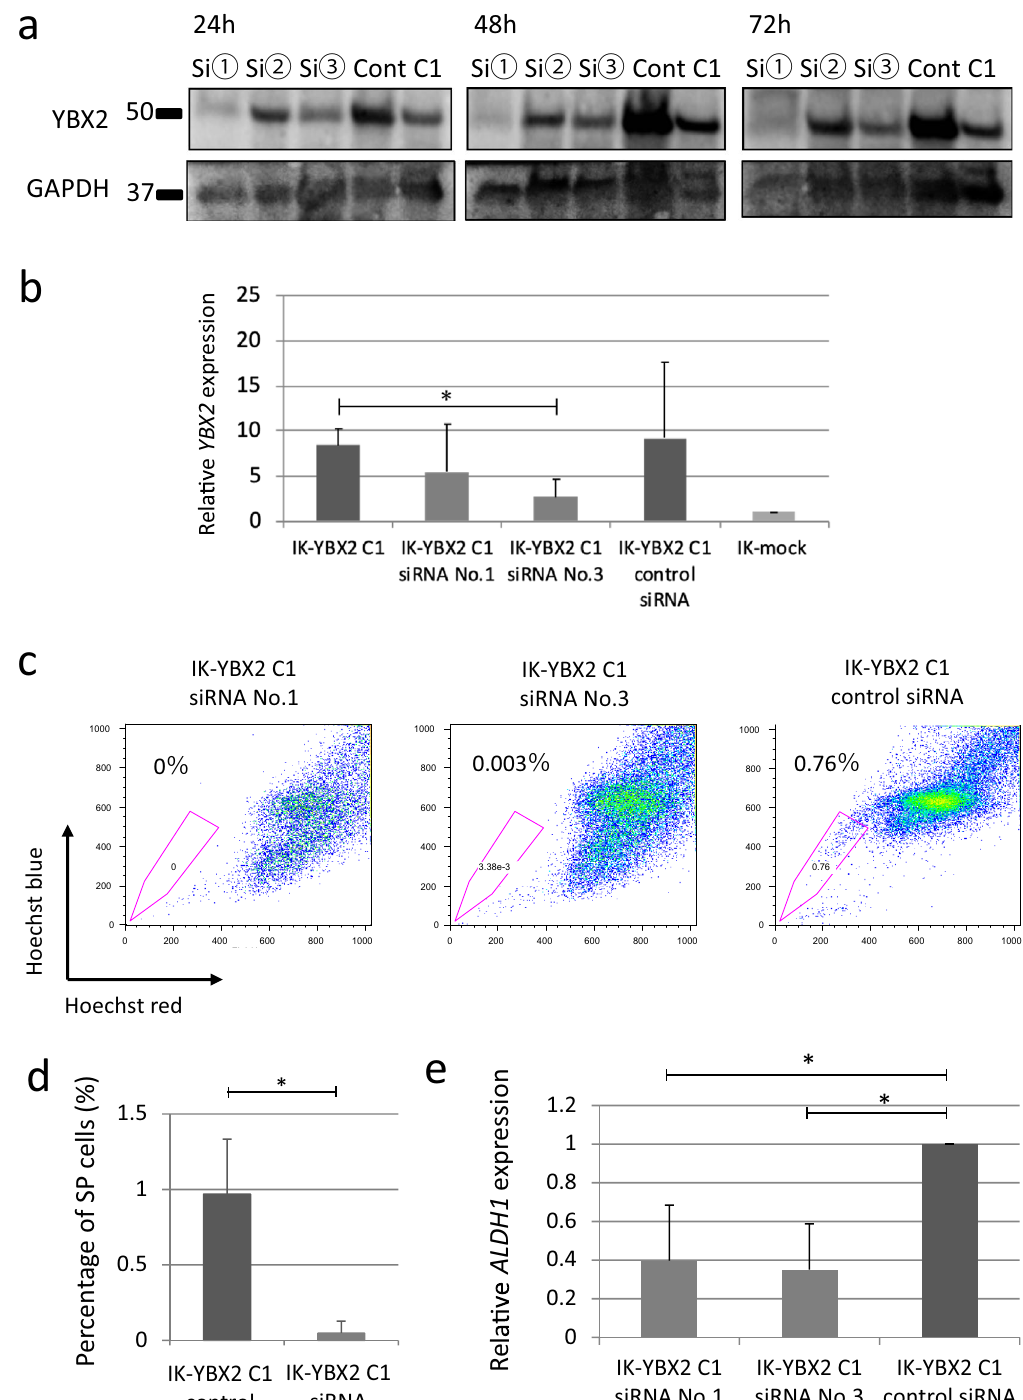
Figure 2. The effect of the knockdown of YBX2. ( a ) The level of YBX2 protein expression was investigated by Western blotting. Full length blots are shown in Supplementary Fig. S5b online. ( b ) The level of YBX2 gene expression using two siRNAs (No.1 or No.3) was investigated by real-time PCR. GAPDH level was used as internal standards. Relative ratios are represented as the means ± SD from three independent experiments (* p < 0.05). ( c ) Downregulation of YBX2 protein using two siRNAs led to significant decreases in the population of SP cells compared with that using control siRNA. ( d ) The percentage of SP cells was decreased in IK-YBX2 C1 siRNAs cells compared with IK YBX2 C1 control siRNA cell from three independent experiments (* p < 0.05). ( e ) The level of ALDH1 expression was decreased in IK-YBX2 C1 siRNAs No.1 and No.3 compared with IK-YBX2 C1 control siRNA cell. HPRT level was used as internal standards (* p <